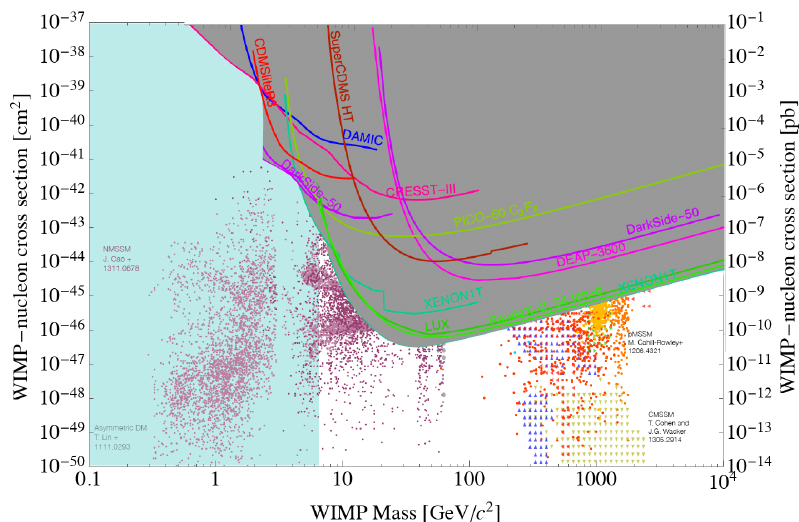
Figure 25: An example of the theory-driven search space for dark matter across a portfolio of plausible theoretical models for dark matter. Superimposed exclusions of that space based on current experimental efforts. Figure generated using [ 38 ]